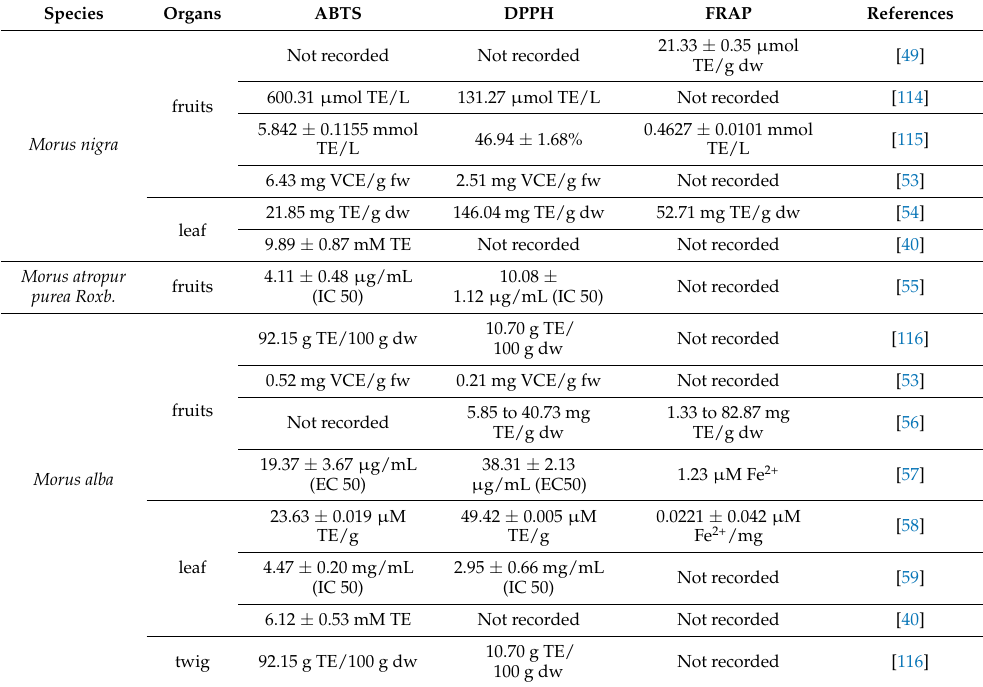
Table 3. The in vitro SET assays that investigated antioxidant capacity of mulberry fruits and leaves from data from the literature